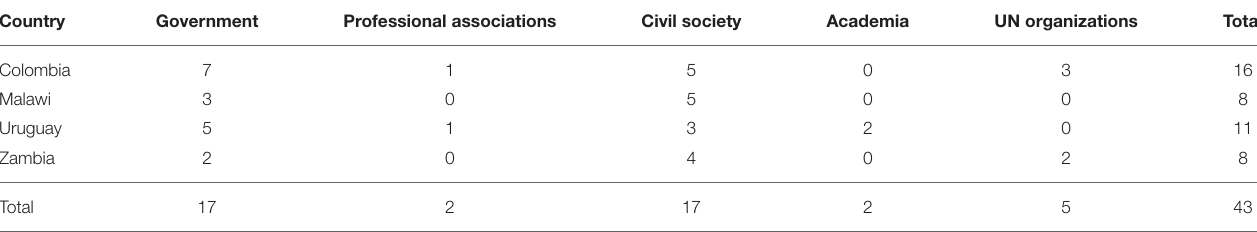
TABLE 1 | Interview participants. Country